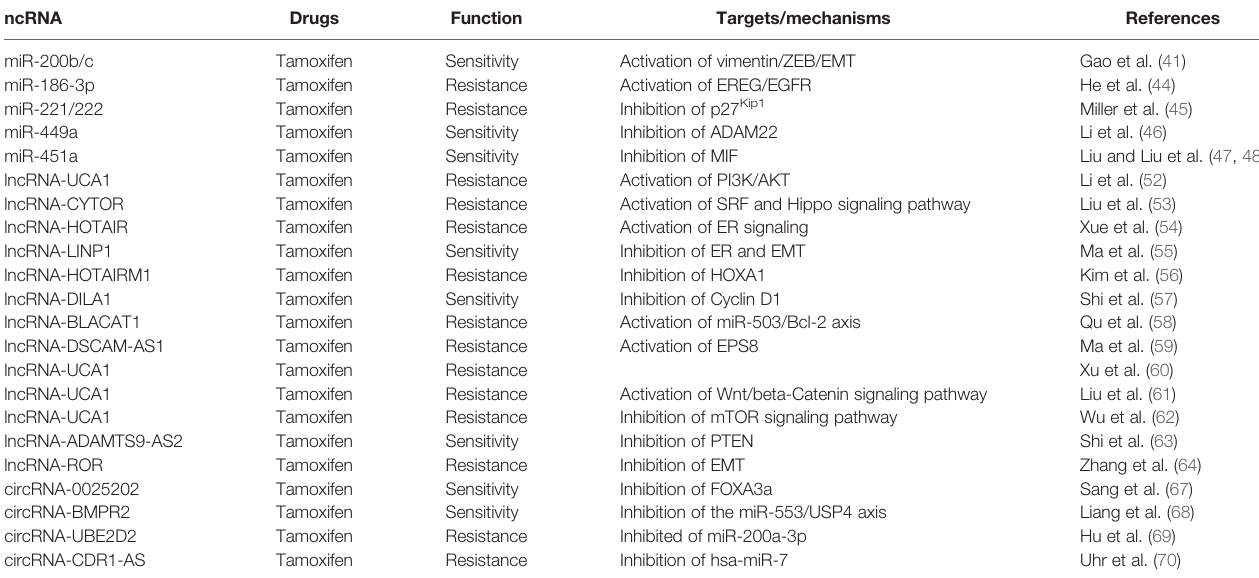
TABLE 2 | Breast cancer tamoxifen chemoresistance-related